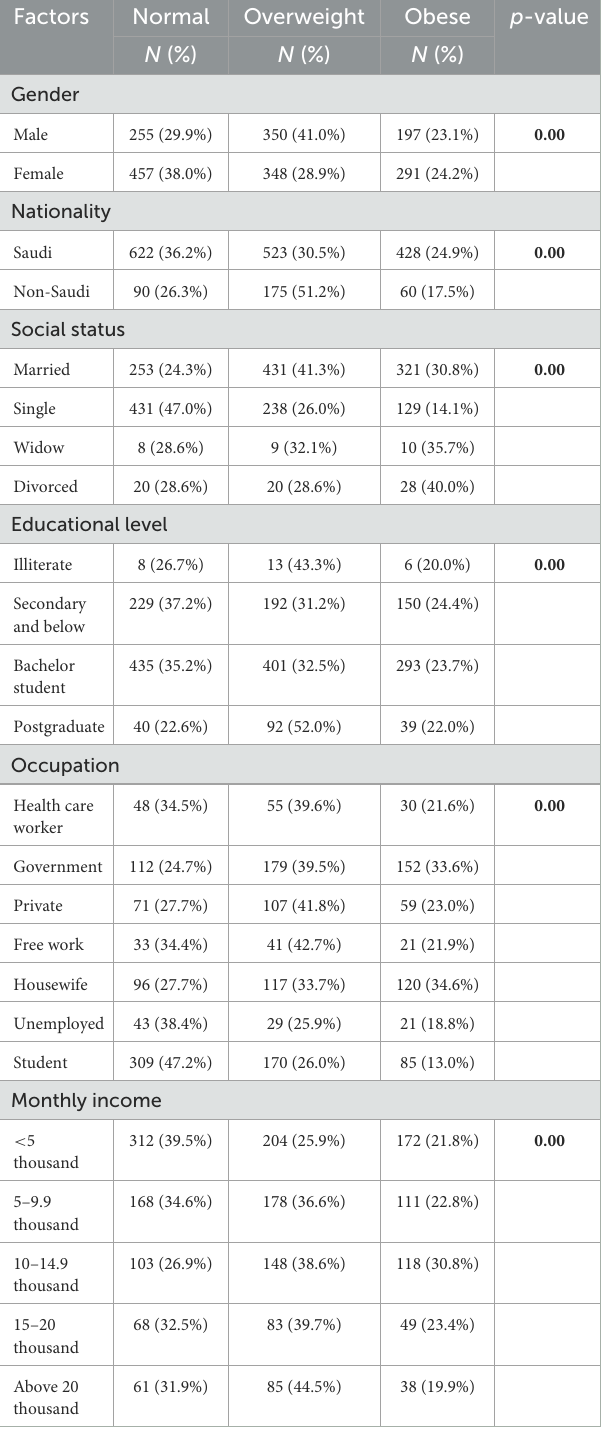
TABLE 3 Comparison of demographic factors with different BMI categories (normal, overweight, and obese).